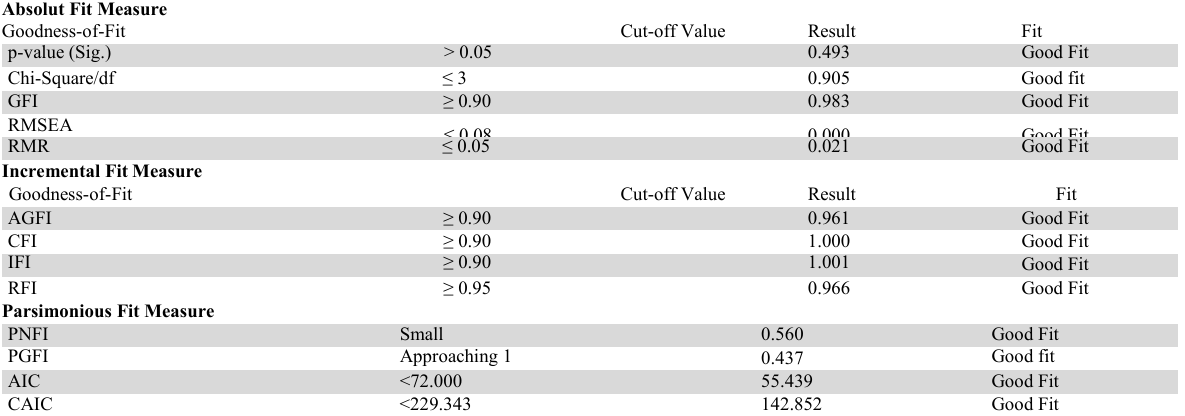
Goodness of Fit of Confirmatory Factor Analysis (CFA) Model of Transformational Leadership (X1) Absolut Fit Measure Goodness-of-Fit Cut-off Value